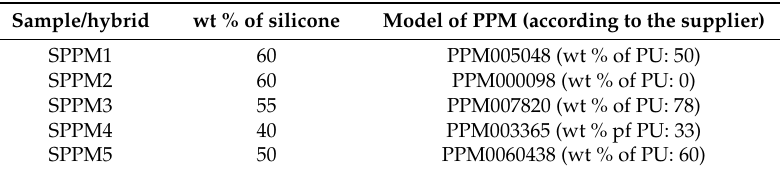
Table 1. Components of five SPPM hybrids.